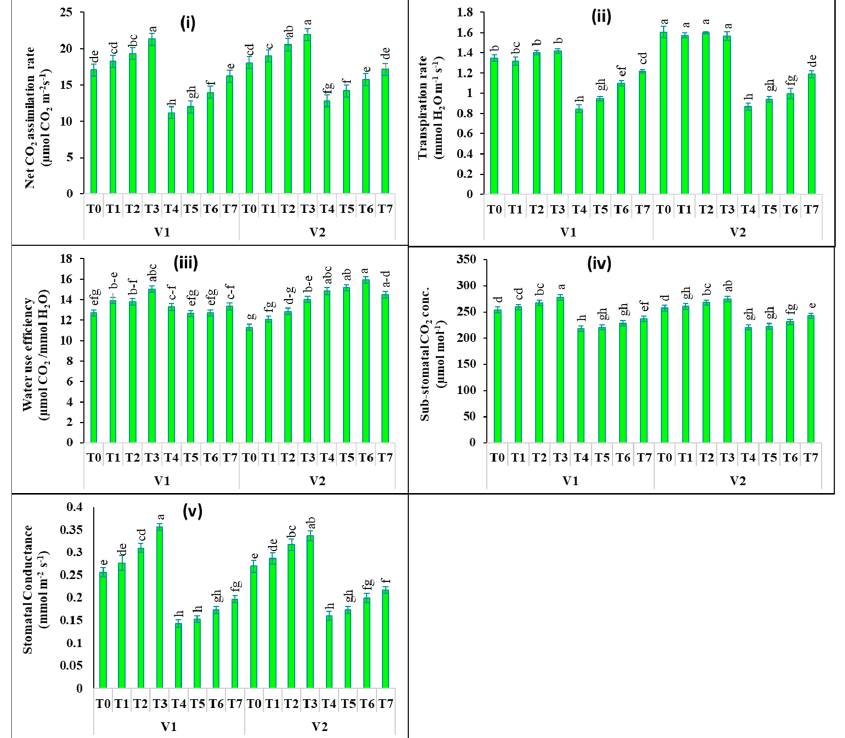
Figure 3. Influence of salicylic acid priming on ( i ) net CO 2 Assimilation rate, ( ii ) transpiration, ( iii ) water use efficiency, ( iv ) sub-stomatal CO 2 concentration, and ( v ) stomatal conductance under salt stress; T0 (control), T1 (hydropriming), T2 (10 mM SA priming), T3 (20 mM SA), T4 (170 mM NaCl), T5 (170 mM NaCl + hydropriming), T6 (170 mM NaCl + 10 mM SA priming), and T7 (170 mM NaCl + 20 mM SA priming); bars sharing same case letter or without lettering, for a parameter, do not significantly differ ( p ≤ 0.05) by the LSD test.